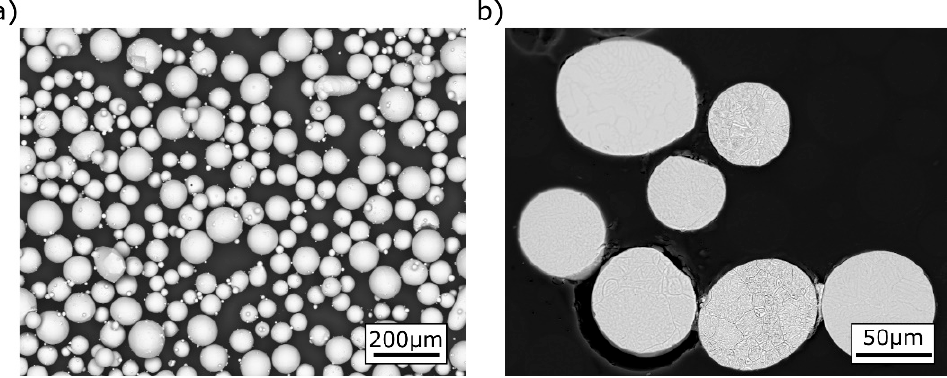
Figure 2. SEM/BSD images of Ti-55511 powder: ( a ) general view; ( b ) cross-sections [17].